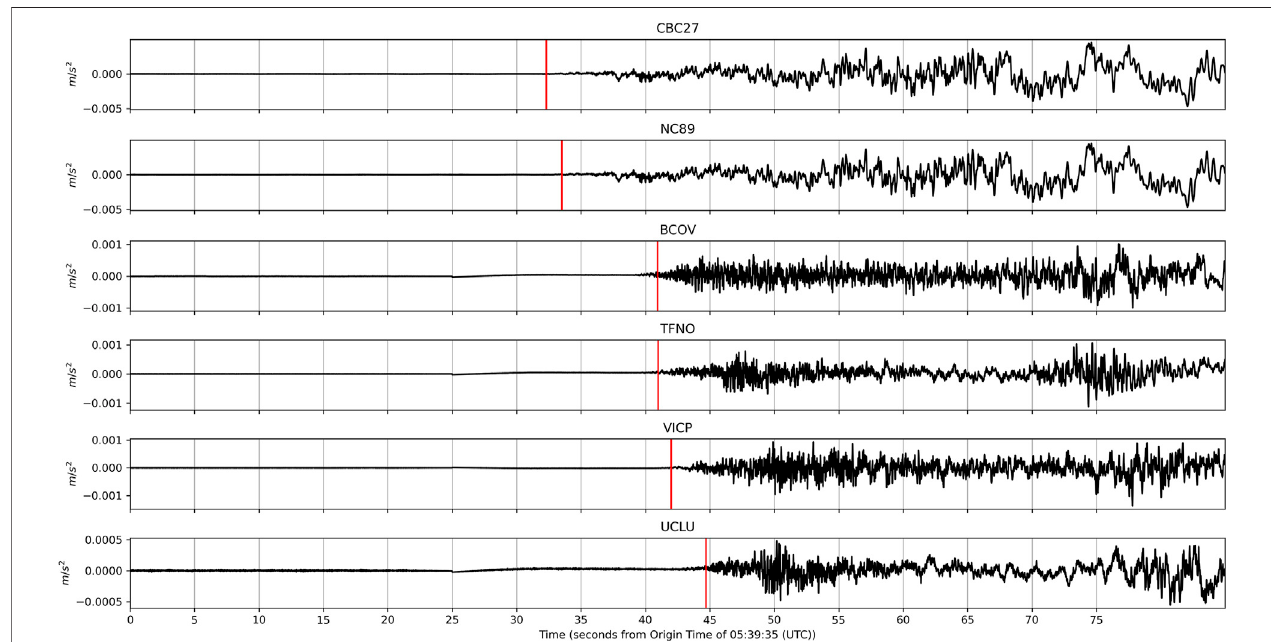
FIGURE8| Waveformsthatcontributed tothe fi rst noti fi cation forthe Sovancoearthquake thathappened on October 22, 2018.Time isgivenin seconds after the origintime(5:39:35UTC)asidenti fi edintheNRCancatalog.The fi rsttwowaveformswererecordedatoffshorestations(CBC27:CascadiaBasin:ODPSite1027,NC89: Clayoquot Slope — ODP Site 889) while the following four traces were recorded onshore (BCOV: Beaver Cove, TFNO: To fi no, UCLU: Ucluelet, VICP: Victoria Peak). Site locationsareshownin Figure1 .TheparametricdatafromthesesitescanbeobtainedfromOceanNetworksCanadaSociety(2021).Rawwaveformdatafromthe subsea instruments can be obtained from Ocean Networks Canada,